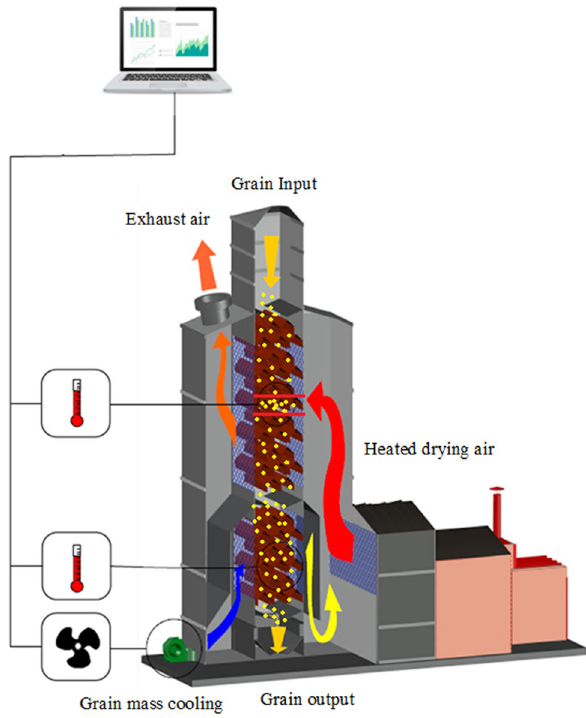
Figure 1. Schema of the dryer system (Software SolidWorks @ , student version, https:// www. solid works. com/ pt- br/ produ ct/ stude